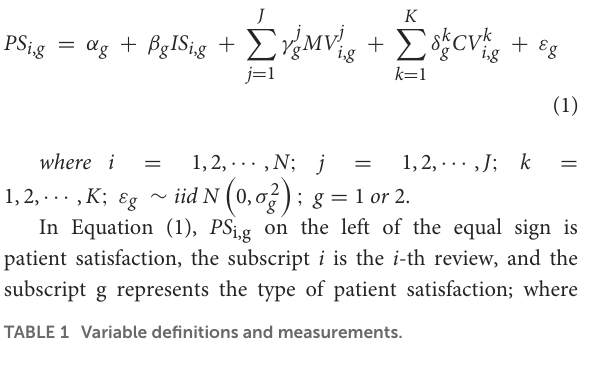
TABLE 1 Variable definitions and